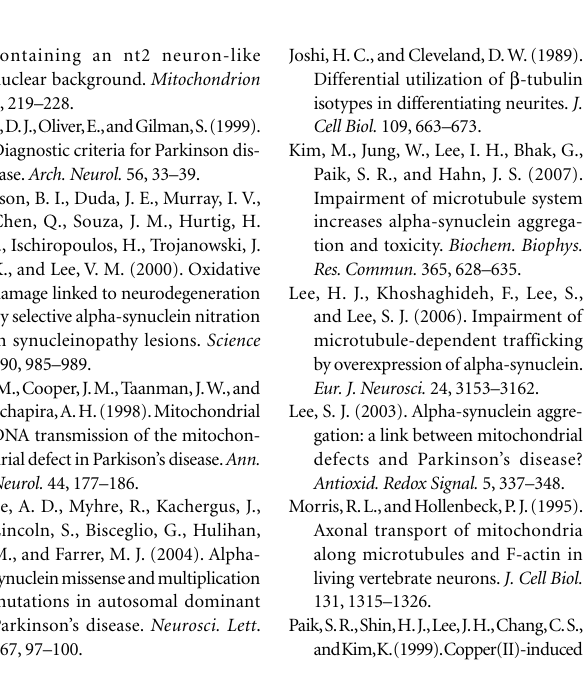
FIGURE 3 | Effects of taxol on tubulin and alpha synuclein. (A) SDS-PAGE showing the effect of 5 nM taxol on free/polymerized tubulin ratios. (B) Densitometry analysis indicated after correcting for GADPH content, 5 nM taxol reduced the free/polymerized tubulin ratio in the PD but not the CT cybrid cells. (C) PAGE showing the effect of 5 nM taxol on